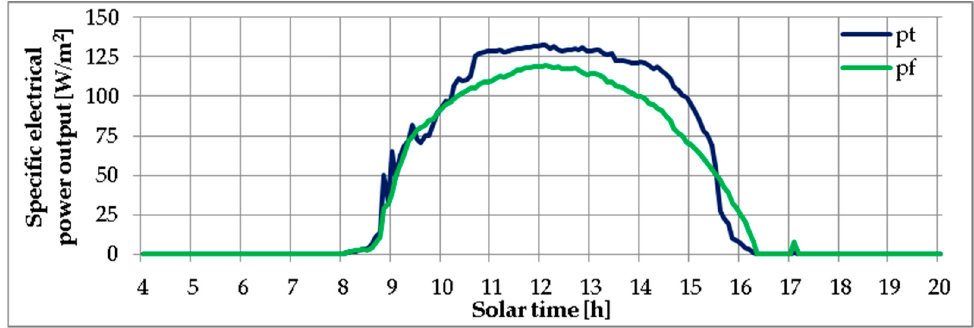
Figure 14. Specific electrical output of the tracked ( p t ) and fixed ( p f ) PV platforms on 12 January 2022.